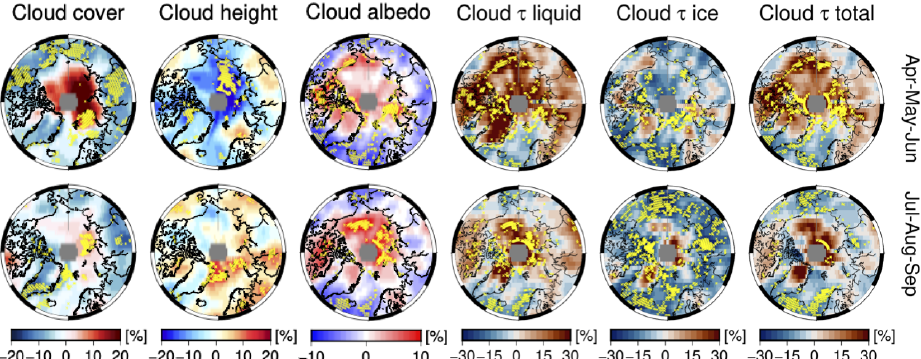
Figure 9. For cloud cover (CFC), height (CTH), cloud albedo (CA) at 600nm, and optical thickness (COT, τ ) of all, liquid, and ice clouds, the panels show their seasonal breakdown. The trend values in percent (%) are relative to the property value at the start year (1996) in the record. Stippling in yellow indicates statistical significance at 95%